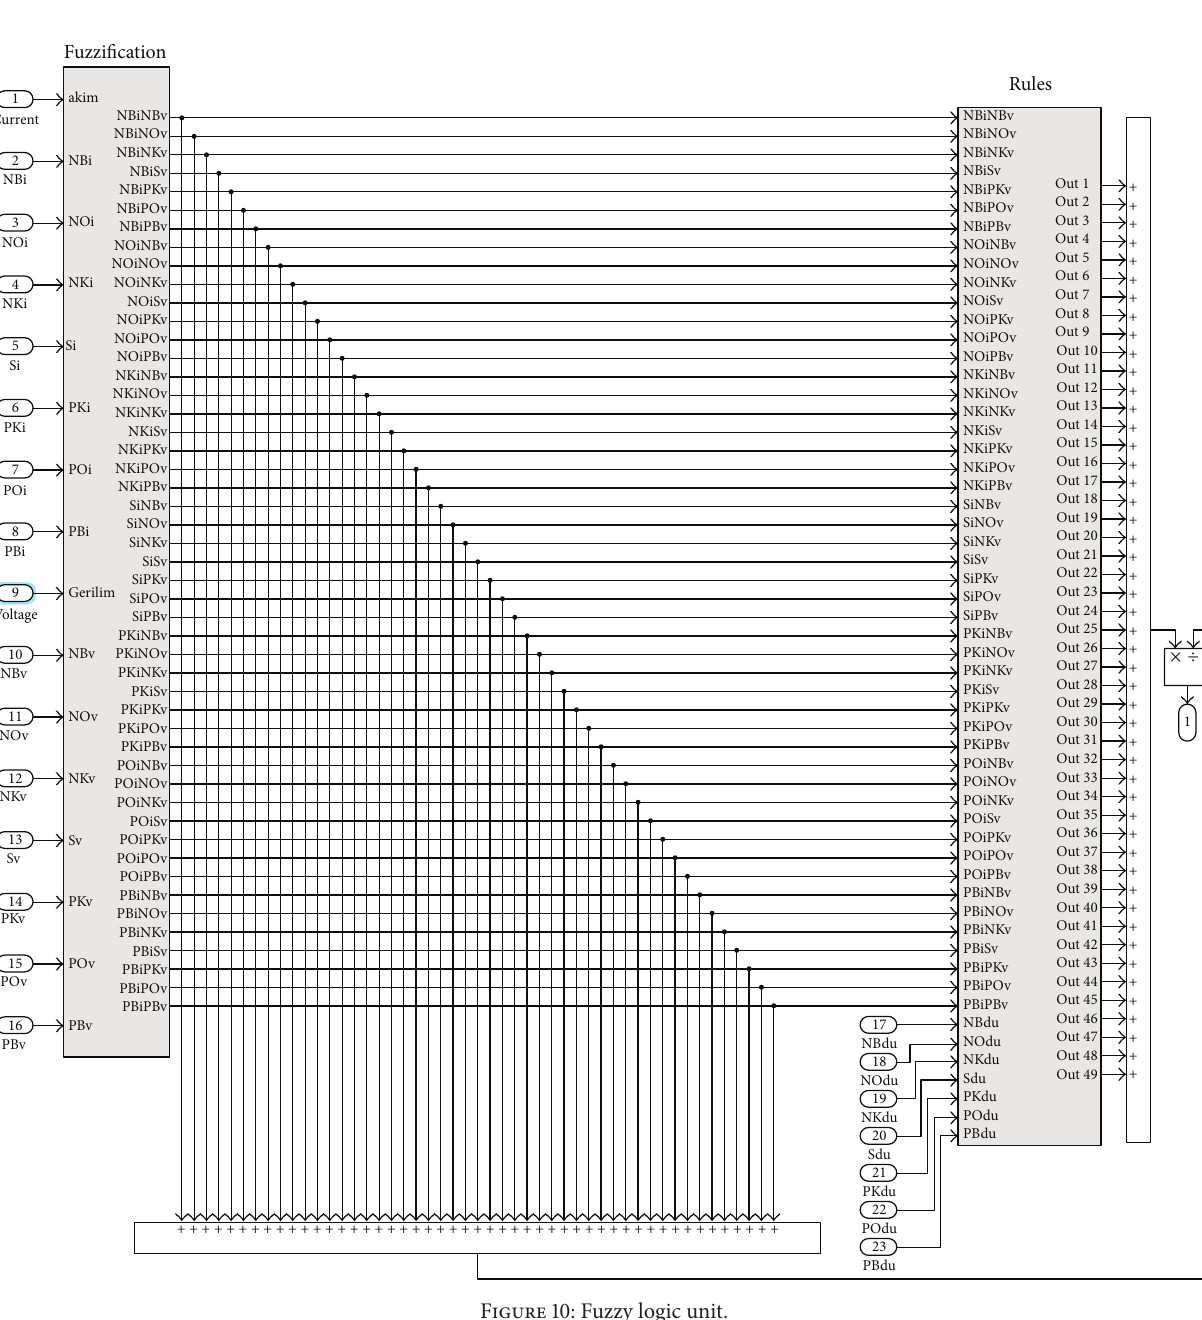
Figure 10: Fuzzy logic